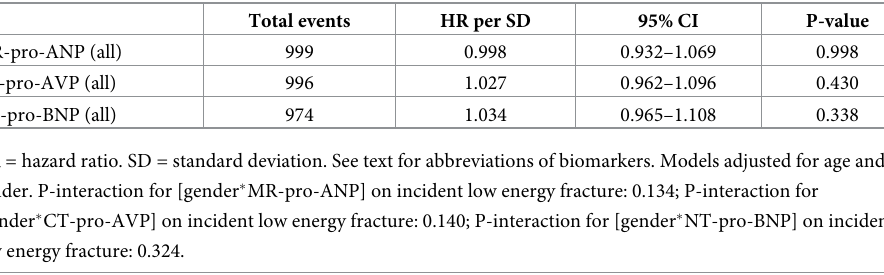
Table 4. The association between other biomarkers and incident fractures.